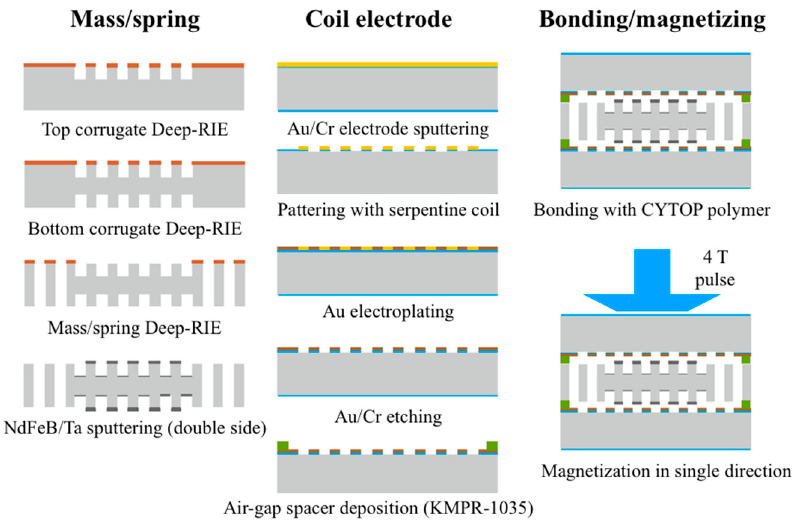
Figure 2. Fabrication process flow of double-sided EMG